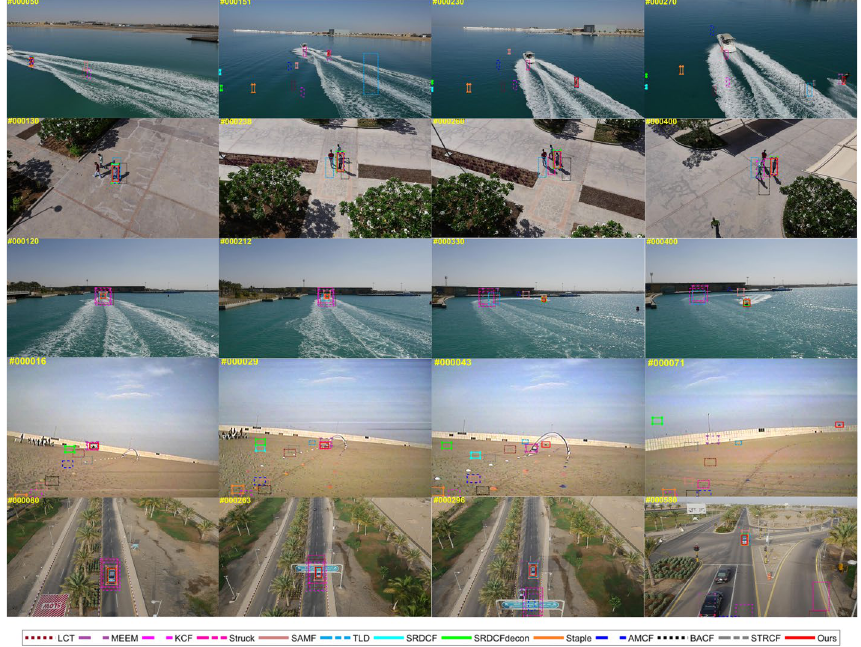
Fig. 10 Visualization of the tracking results of all trackers on five challenging sequences. (# Number on the left corner of each image denotes the frame index. From top to bottom are wakeboard3, group1_1, boat9, uav3, and car9